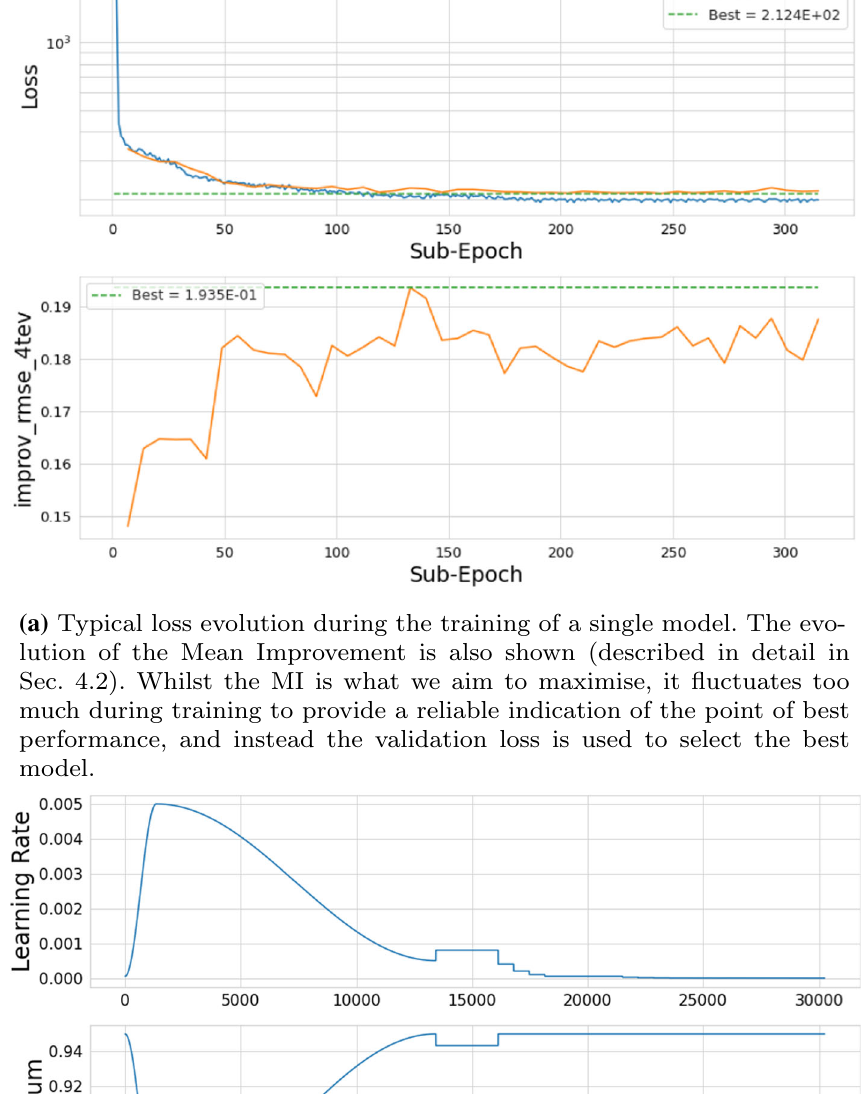
Fig. 7 Details of a typical training, showing the loss and metric evolution and the associated schedule of